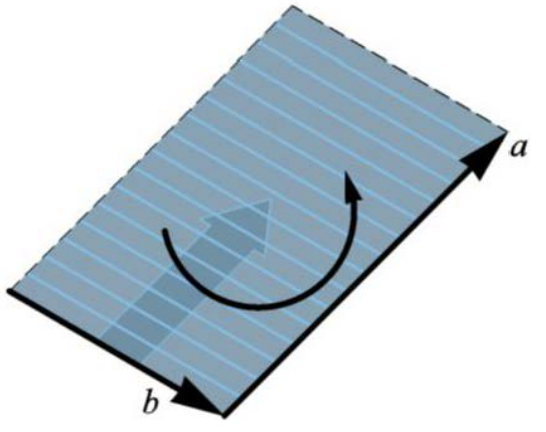
Figure 9: The extension of vector b along vector a provides the geo- metric interpretation of the outer product b ∧ a .